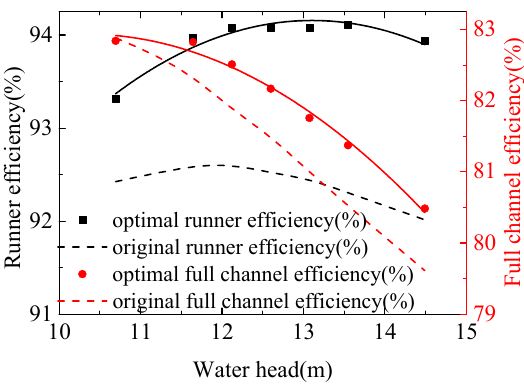
Figure 17. Hydraulic efficiency comparison between optimal turbine and original turbine.